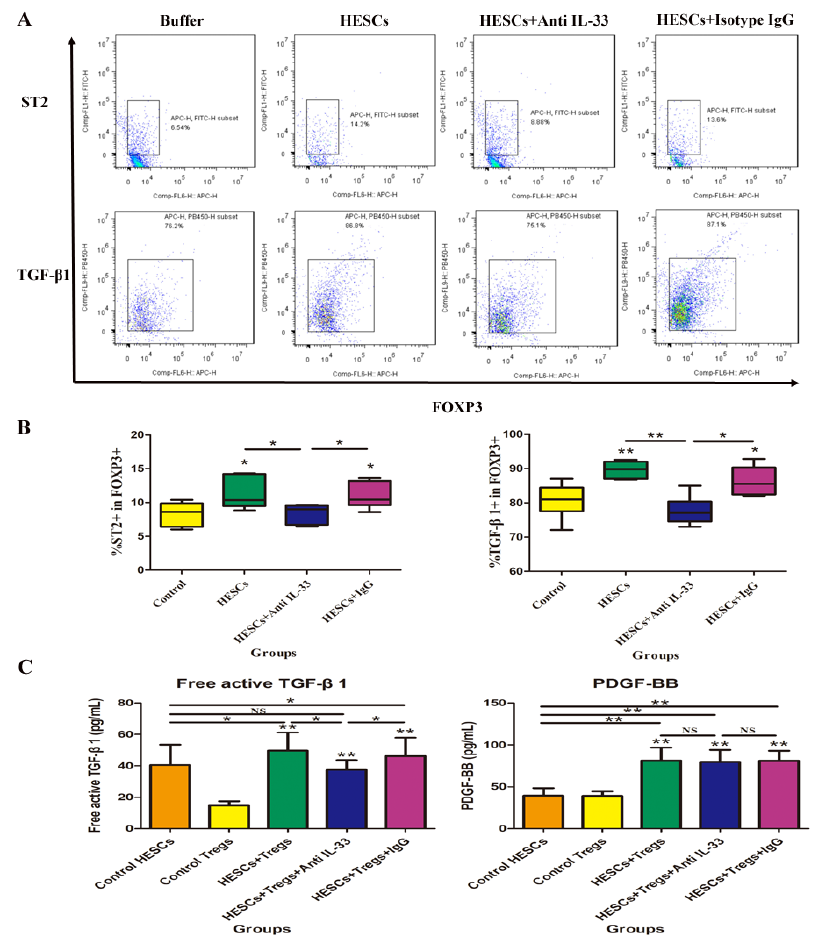
Figure 5. IL-33 induces the expression of ST2 and TGF- β 1 in Tregs. Blood Tregs were cultured alone, co-cultured with endometriotic stromal cells or in the presence of the anti-IL-33 antibody or mock isotype IgG. After 48 h, Tregs were collected, stimulated with PMA and ionomycin, and analyzed through flow cytometry for CD4, CD25, FOXP3, ST2, and TGF- β 1. ( A ). Representative flow cytometry images comparing the proportion of ST2- or TGF- β 1-expressing Tregs. ( B ). Cumulative data comparing the proportion of ST2-or TGF- β 1-expressing Tregs. The marks on the three groups of co-culture indicate the comparison between the testing group and the control group. ( C ). Concentration of free active TGF- β 1 and PDGF-BB in the medium of indicated conditions for 48 h. The marks on the three groups of co-culture indicate the comparison between the testing group and the control Tregs group. NS: not significant; *: p < 0.05; **: p < 0.01. Data are presented in means ± SDs.